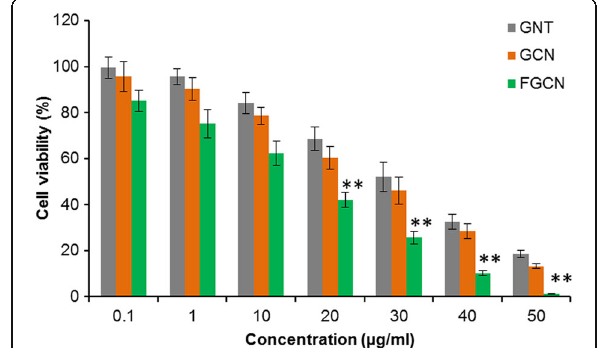
Fig. 5 In vitro cytotoxicity analysis of GEN, GCN, and FGCN in HeLa cancer cells. The cells were treated with the respective formulations and incubated for 24 h. ** p < 0.01 is the statistical difference between FGCN and GEN.A